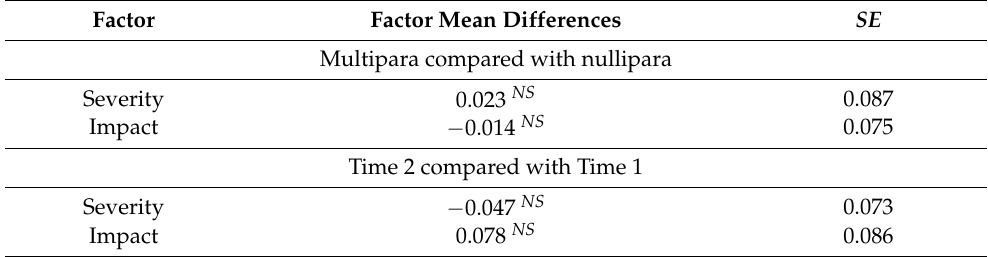
Table 4. Differences in factors’ latent means and SE values of primiparas vs.